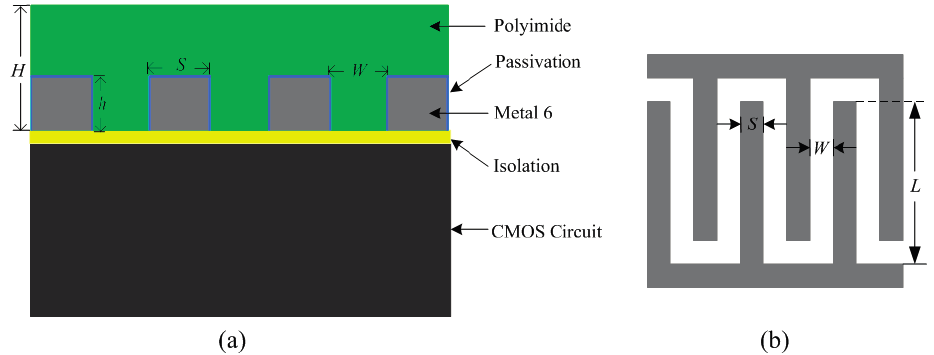
Figure 3. Proposed humidity sensor: ( a ) humidity sensor structure and ( b ) top view of the humidity